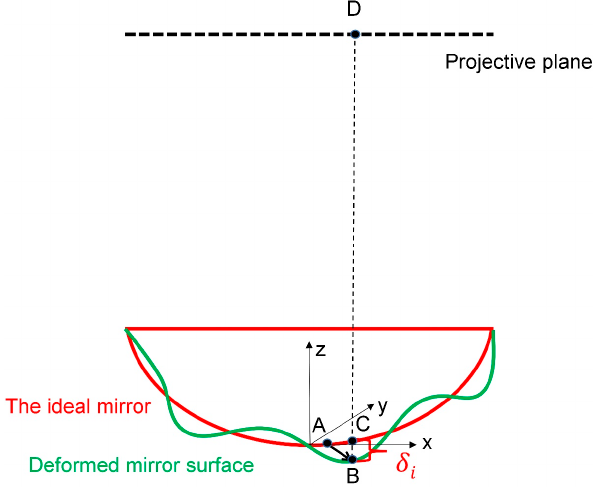
Figure 1. The schematic representation of the projection of deformed mirror surface and the sag displacement of the projection node. A: (x ,y ,z ) i i i ; B: (x